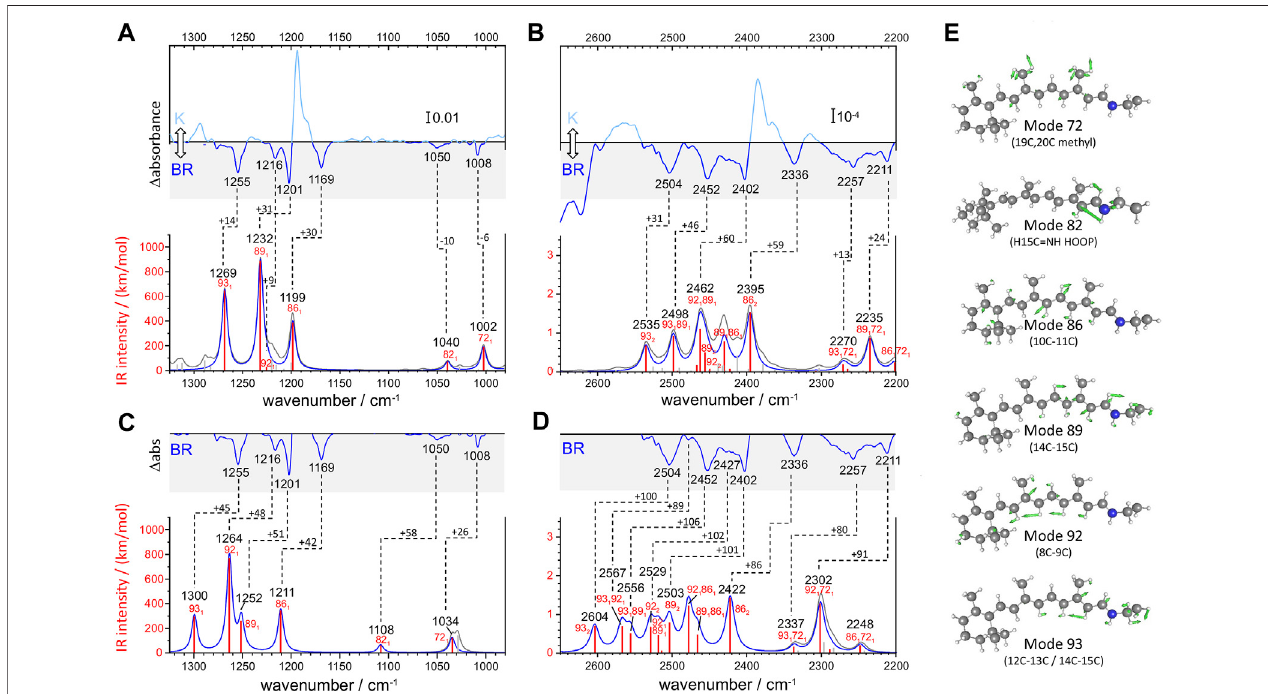
FIGURE 3 | Calculated versus experimental IR spectra of all- trans PSB retinal in BR. (A,B) Calculation with scheme A vs. experimental K-BR spectrum. (C,D) Calculation with scheme B vs. experimental K-BR spectrum (only the negative bands from the BR state are shown). Bands assigned to a common vibrational transition are connected bydashes lines. See text and Materials and Methods for details about calculationswith scheme Aand schemeB. (A – D) Wavenumbers and IRintensities of calculated vibrational transitions (gray vertical lines). Transitions from modes with experimentally detected fundamentals (modes 72, 82, 86, 89, 92, and 93) are highlighted in red. Spectra were generated from the calculated intensity of vibrational transitions by convolution with a Lorentzian band (gray trace and blue traces), of either (A,B) 7 cm − 1 or (C,D) 14 cm − 1 full width at half height. Transitions are labelled as x 1 , x 2 , or x 1 y 1 , for fundamental, overtones and combination transitions, respectively. (E) Atom displacements for some selected vibrational